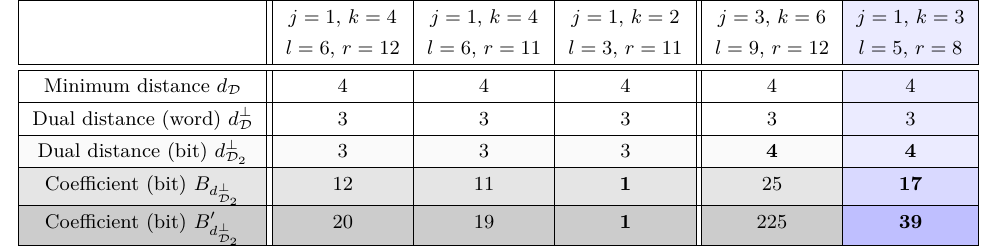
Table 5: Exhibiting different codes in (5 , 2)-SSS scheme over F 2 4 . Note that we take α 1 = α i = 1, α 2 = α j , α 3 = α k , α 4 = α l and α 5 = α r